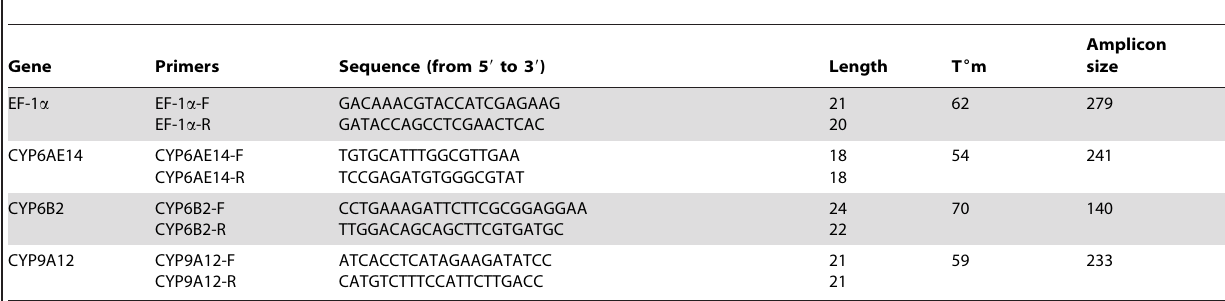
Table 1. Primers used for amplification and quantification of Helicoverpa armigera cDNA.